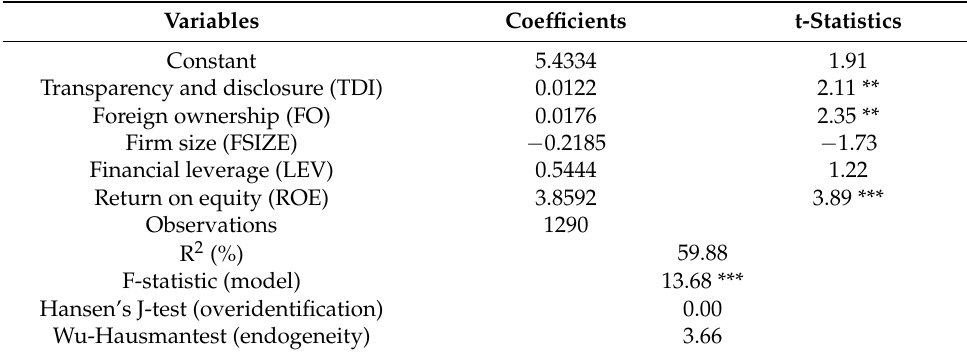
Table 4. Estimated results of the GMM